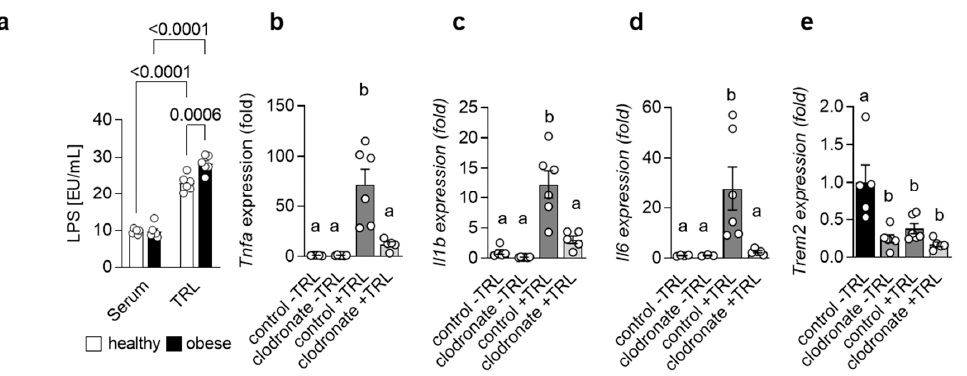
Figure 1. LPS-containing TRLs elicit a macrophage-dependent pro-inflammatory response in the liver ( a ) LPS levels were measured in serum and TRL particles isolated from healthy and obese patients ( n = 6). ( b – e ) Mice were pre-treated or not with clodronate to deplete macrophages and then injected without or with LPS-containing TRL particles. Liver tissue was harvested 4 h after injection. Hepatic gene expression of Tnfa ( b ), Il1b ( c ), Il6 ( d ) and Trem2 ( e ) ( n = 5–6). Data are shown as mean + SEM. Statistically significant differences between groups ( p < 0.05) were determined by two-way ANOVA and are indicated as p -value ( a ) or as different letters ( b – e ).